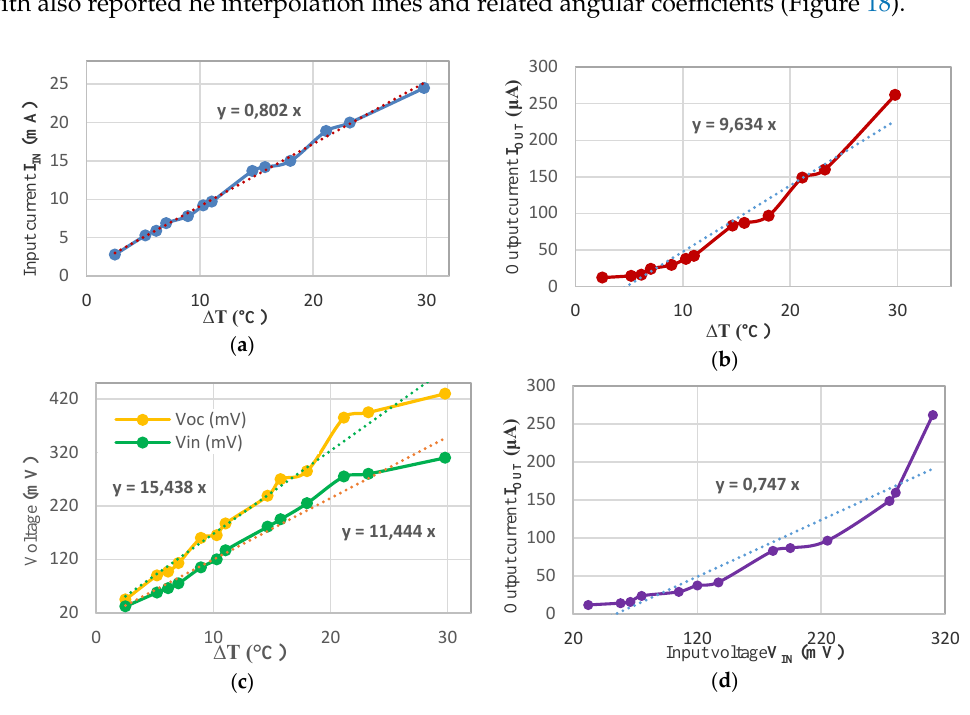
Figure 18. TES1-03102 Mini TEGs characterization: input current I IN ( a ), output current I OUT ( b ), open-circuit V OC and input V IN voltages ( c ) as function of ΔT, and output current I OUT as function of the input voltage V IN ( d ).